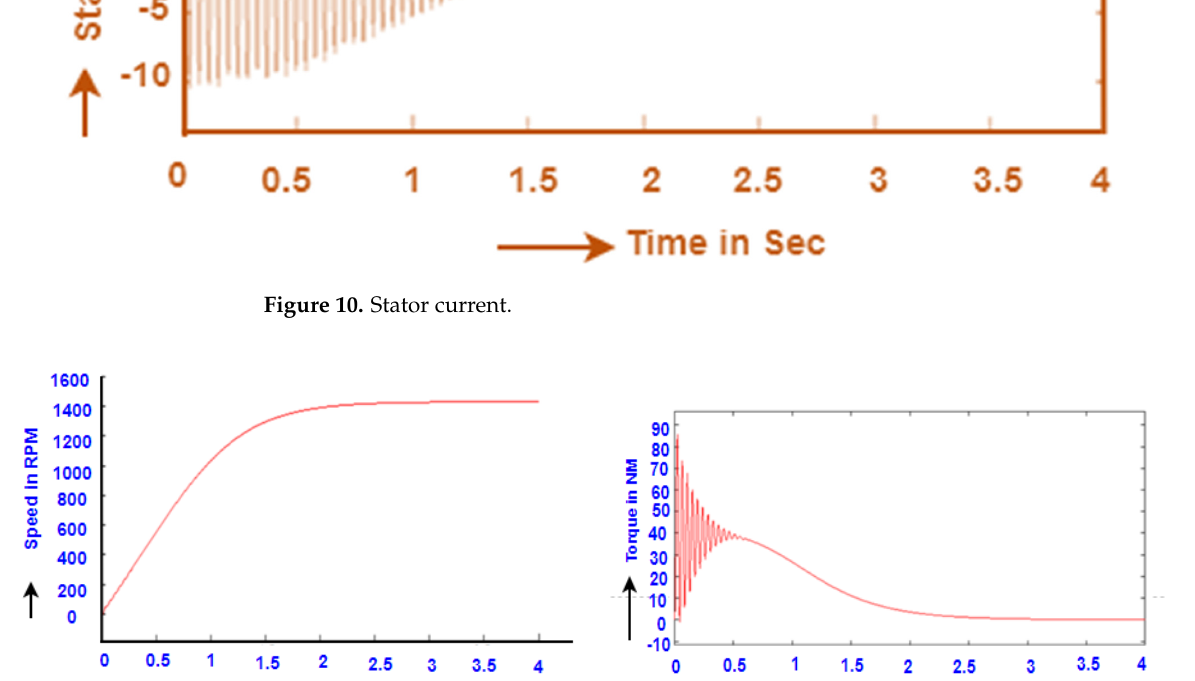
Figure 11. Speed and torque response of an induction